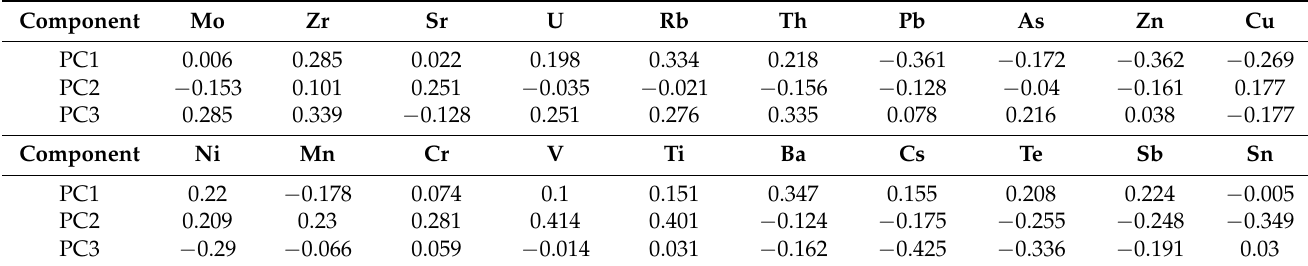
Figure 7. ( a ) Scree plot of eigenvalues of principal components. ( b ) Three-dimensional biplot of principal components for different formations. The formation information is derived from the previous mapping. ( c ) Biplot of principal components (PC1 vs. PC2). ( d ) Biplot of principal components (PC1 vs. PC3) for different formations. Table 3. Component matrix for pXRF soil data after clr